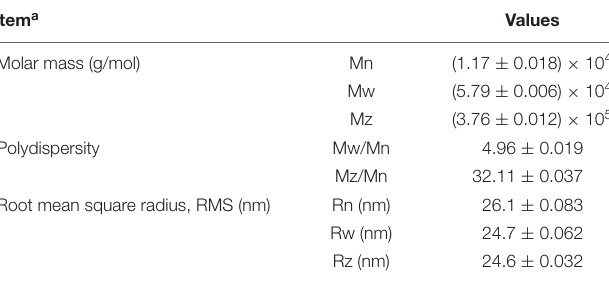
TABLE 2 | The molecular weight, polydispersity, and root mean square (RMS) radius of LJPS. Item a